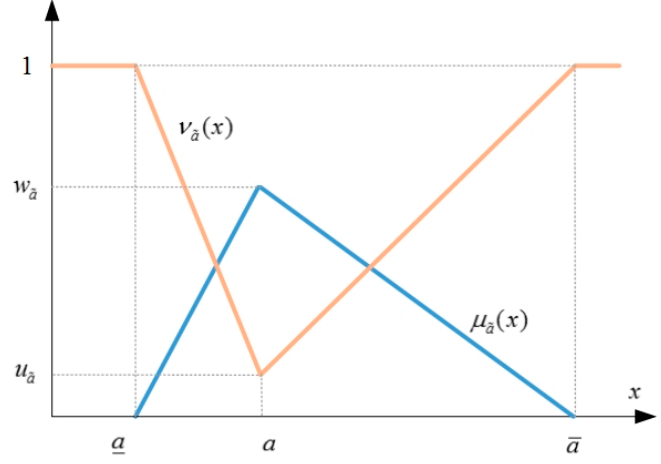
) , u . Figure 2. A TIFN (cid:101) a = (( a , a , a ) ; w (cid:101) a (cid:101) a a